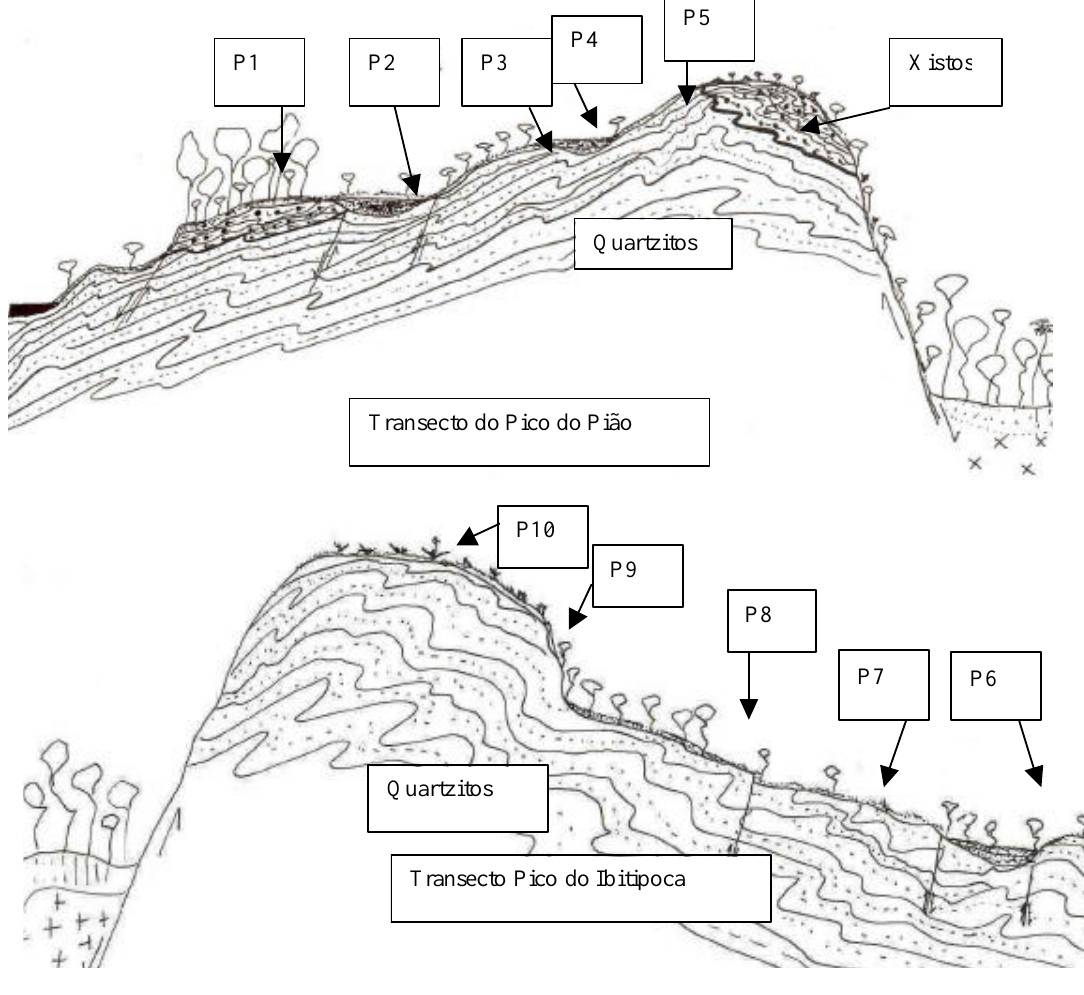
Figura 1. Corte esquemático dos dois transectos de solos estudados (perfis P1 a P10), ilustrando as principais feições da geologia e geomorfologia do Parque Estadual do Ibitipoca. A direção da xistosidade e das falhas são aproximadas. O eixo vertical da figura mede aproximadamente 500 m, e o eixo horizontal 2.000